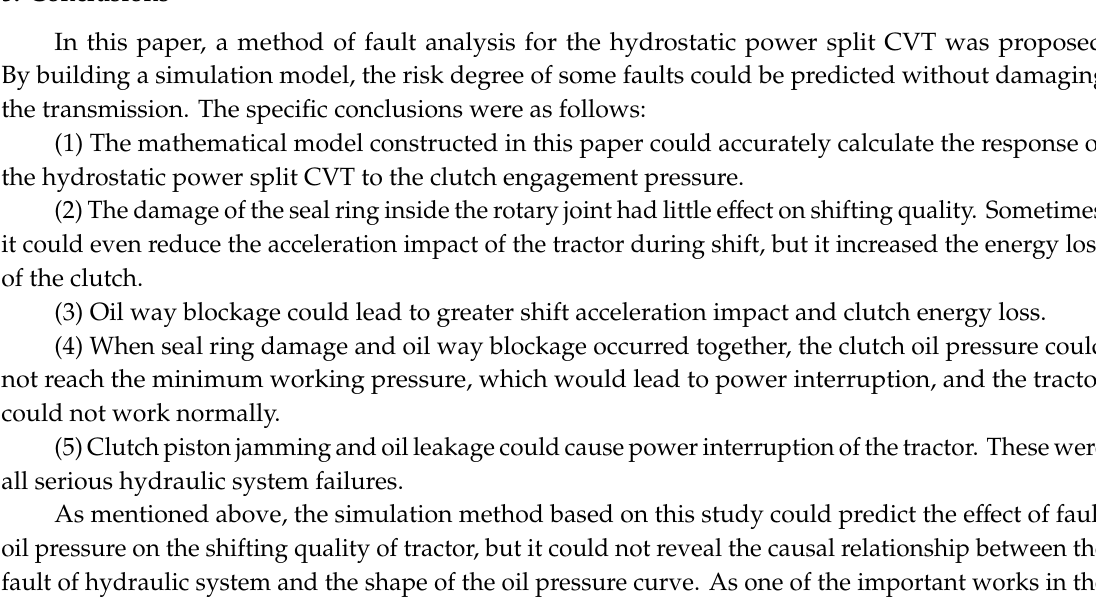
Figure 13. Shifting quality of the CVT tractor under different failure modes.